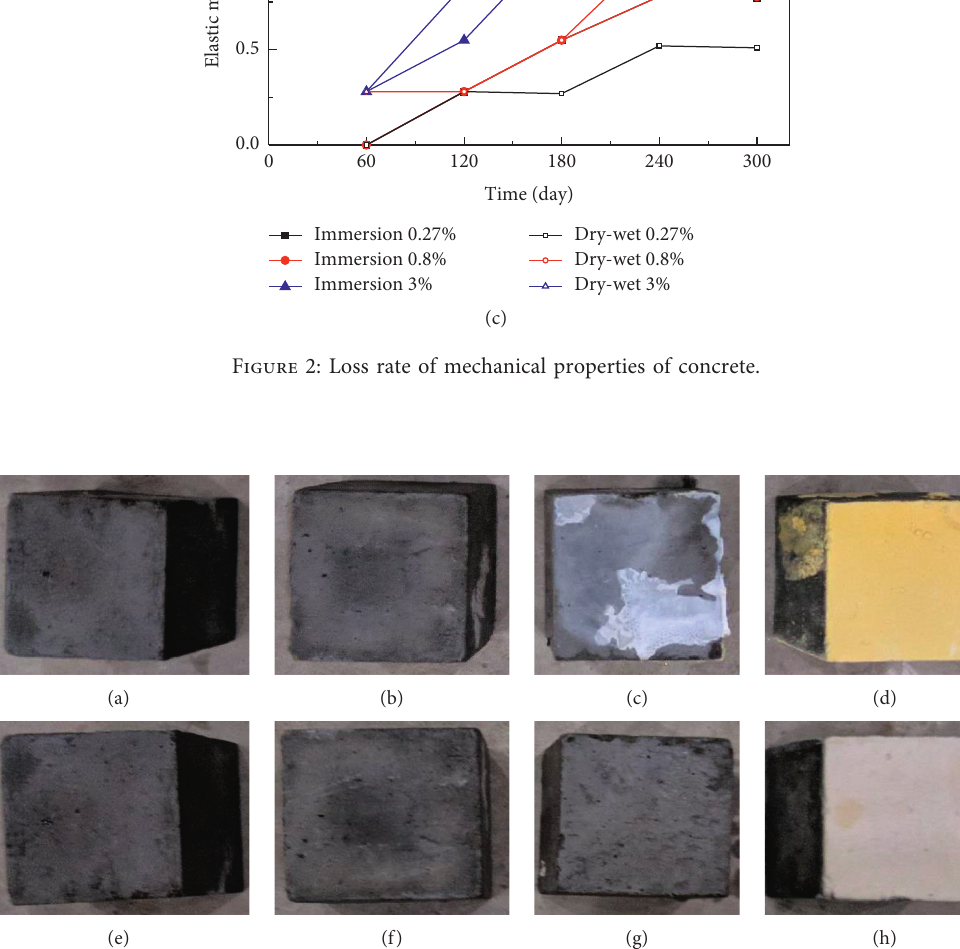
Figure 3: Concrete specimens after 300 days of corrosion: (a) immersion 0%, (b) immersion 0.27%, (c) immersion 0.8%, (d) immersion 3%, (e) dry-wet 0%, (f) dry-wet 0.27%, (g) dry-wet 0.8%, and (h) dry-wet